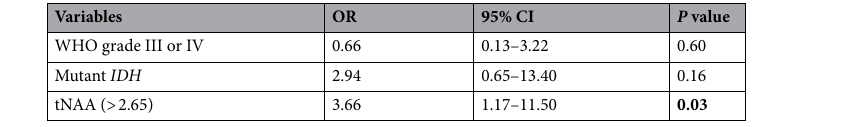
Table 6. Multivariable analysis of factors associated with preoperative seizures in gliomas. WHO World Health Organization; IDH isocitrate dehydrogenase ; tNAA total N -acetyl-l-aspartate.